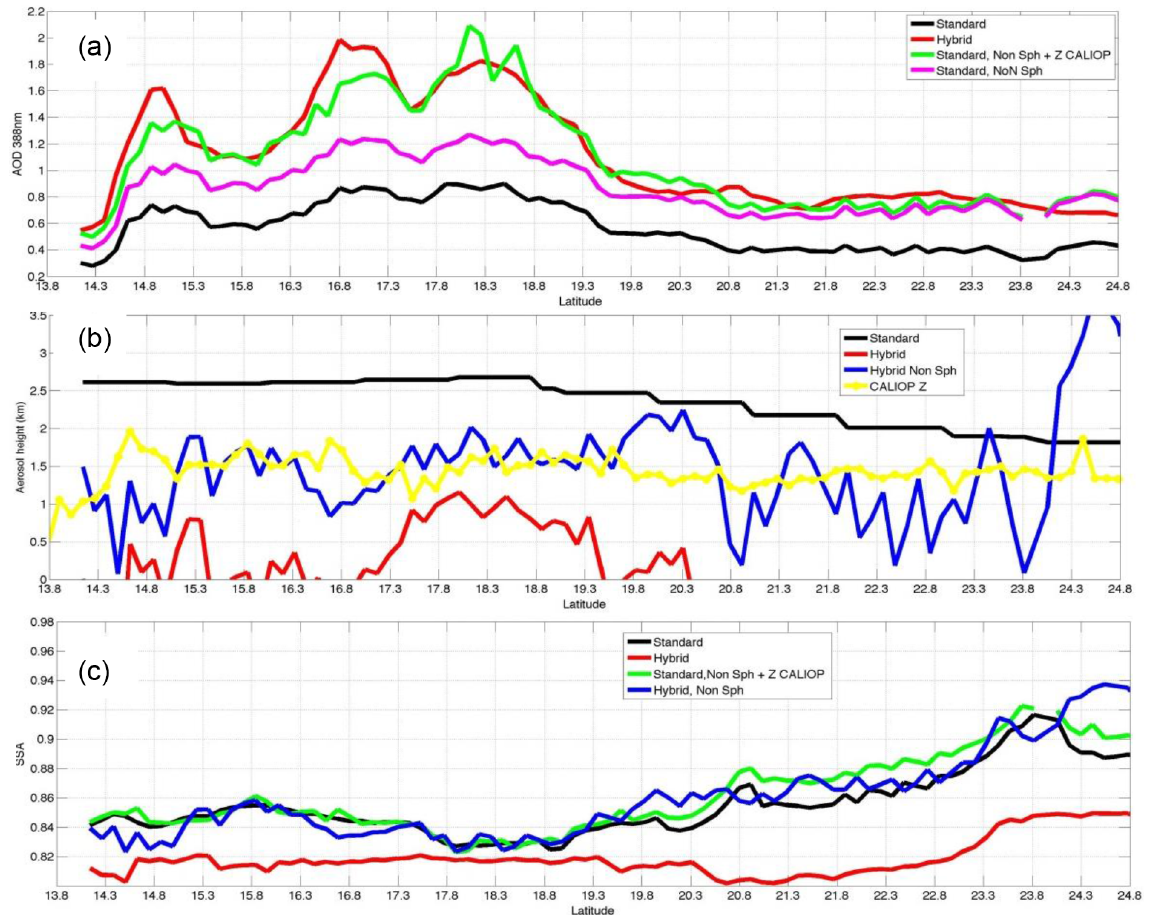
Figure 12. AOD, SSA at 388nm and aerosol height derived by different methods. (a) AOD from the OMAERUV (or standard) algorithm using the default particle shape (spheres) and aerosol height (climatology) (in black), using non-spheres and climatological height (pink), using non-spheres and actual aerosol height from CALIOP (green) and the hybrid AOD (red). (b) Climatological aerosol height (black), CALIOP measured aerosol height (yellow), hybrid aerosol height using the spherical (red) and non-spherical (blue) models. (c) SSA from the standard retrieval (black), from standard retrieval using non-sphere models and measured CALIOP height (green), from hybrid retrievals using sphere (red) and non-sphere (blue)